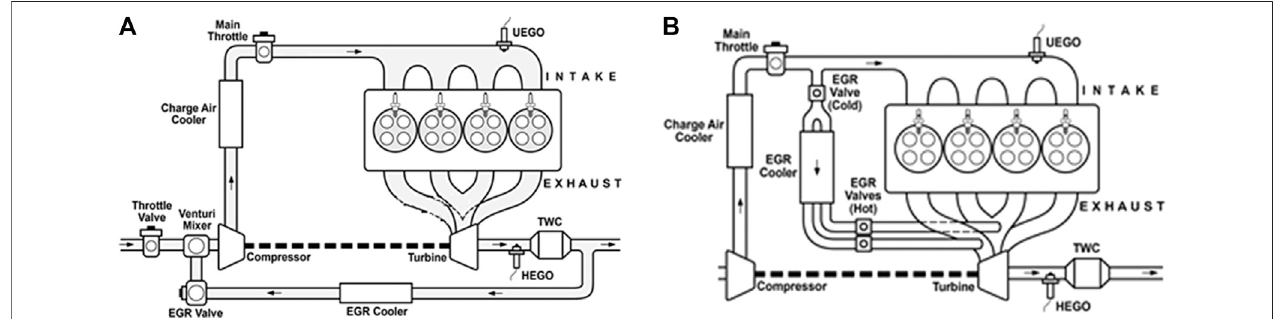
FIGURE 1 | Schematic of a (A, left) LP-EGR system and (B, right) HP-EGR system.